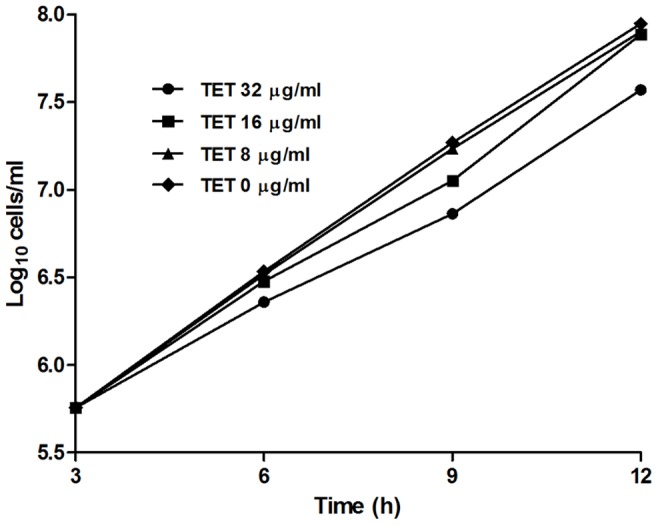
Time-growth curves of different concentrations of TET on C. albicans strain SC5314.